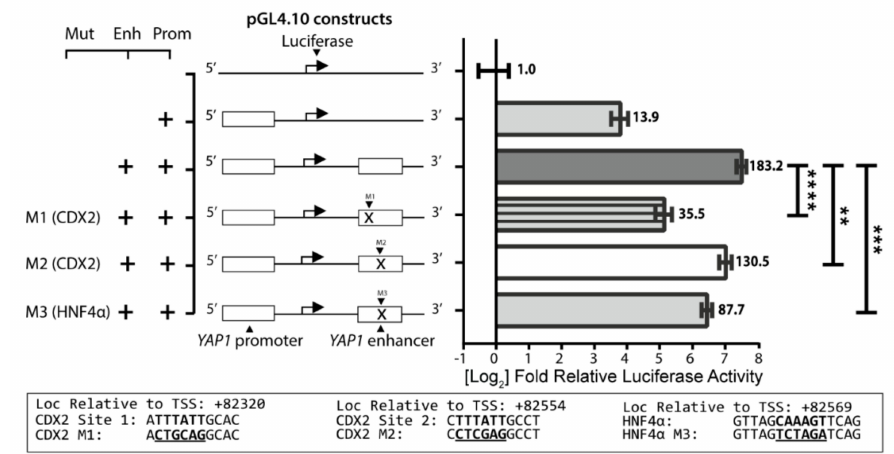
Figure 4. Relative luciferase / β -galactosidase activity from cell lysates of Caco-2 cells transfected with pGL4.10 luciferase reporter constructs containing the YAP1 promoter and + 82 kb enhancer with or without mutated CDX2 and HNF4 α binding sites. The sequence of the three mutated binding sites CDX2 site 1 (M1), CDX2 site 2 (M2), and HNF4 α (M3) is depicted below on the figure. Relative luciferase activity was normalized to the empty pGL4.10 vector. Bars are mean values on a log2 scaled y -axis with SD error bars. + indicates the presence of a YAP1 promotor or enhancer sequence in the luciferase reporter sequence. The bold bases at the bottom indicates the core sequence of the transcription factor binding site and mutated core sequences are underlined. Statistical significance was obtained using